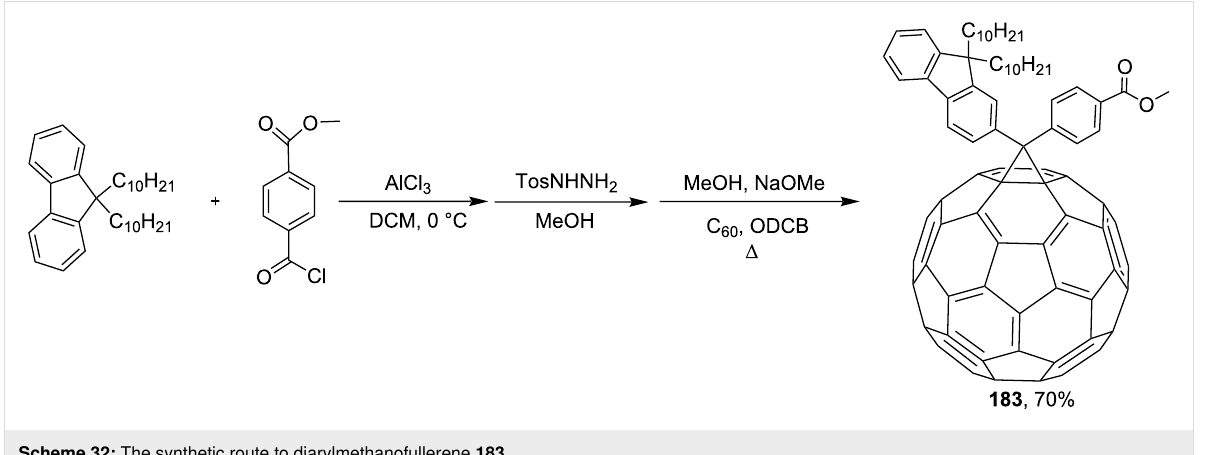
Scheme 32: The synthetic route to diarylmethanofullerene 183